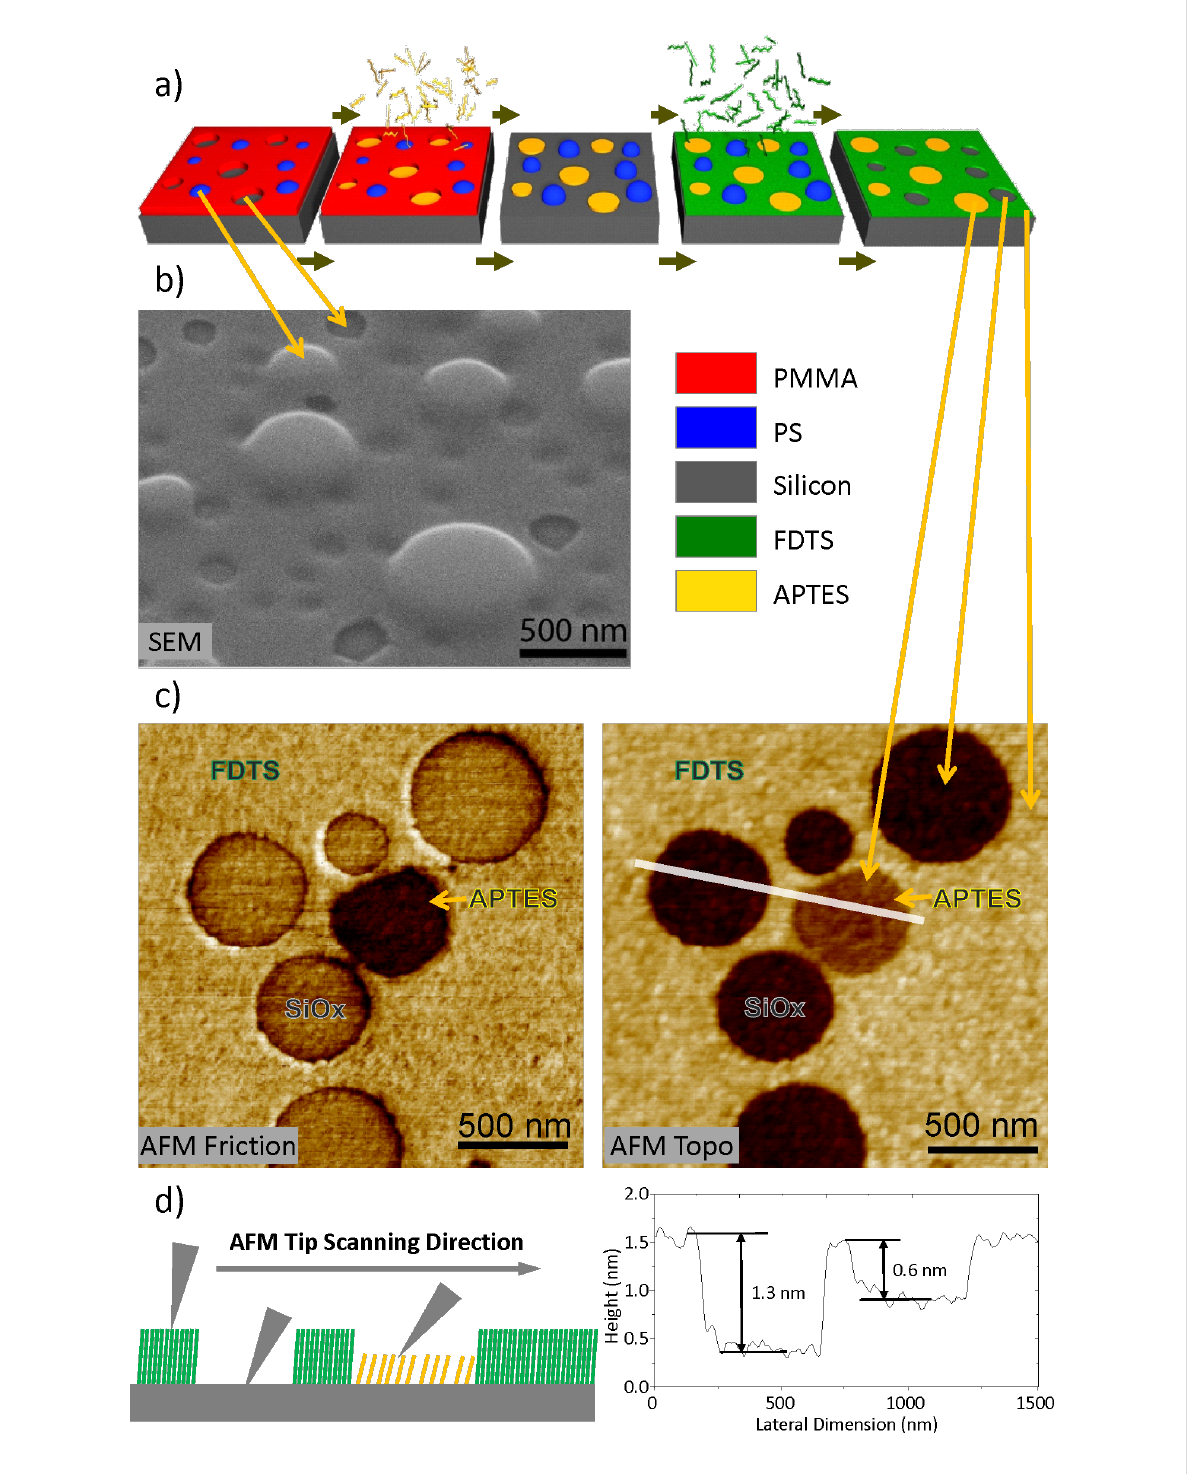
Figure 5: Fabrication of a three-phase SAM template spin cast at the humidity of 65%. (a) Schematic drawing of the process, silicon substrate (grey), PMMA (red), PS (blue), FDTS (green) and APTES (yellow). (b) SEM image of a polymer-blend mask with breath figures. (c) AFM images (both retrace images) of a three-phase SAM template. The cross section shown here is the average of the trace and the retrace images. (d) Schematic drawing of the AFM friction imaging. The first SAM that was deposited is APTES. Its height is half the height of the FDTS-SAM, which was comple- mented after the PMMA mask had been removed. Finally, after the removal of the PS islands the remaining holes have a depth of 1.3 nm, which is independent of the intensity and duration of the snow-jet